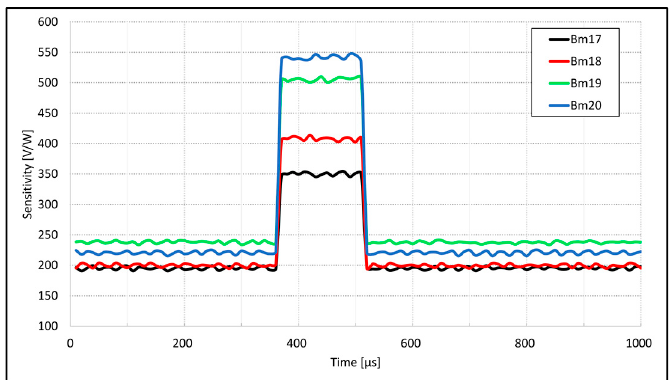
Figure 5. Sensitivity boosting measuring results.